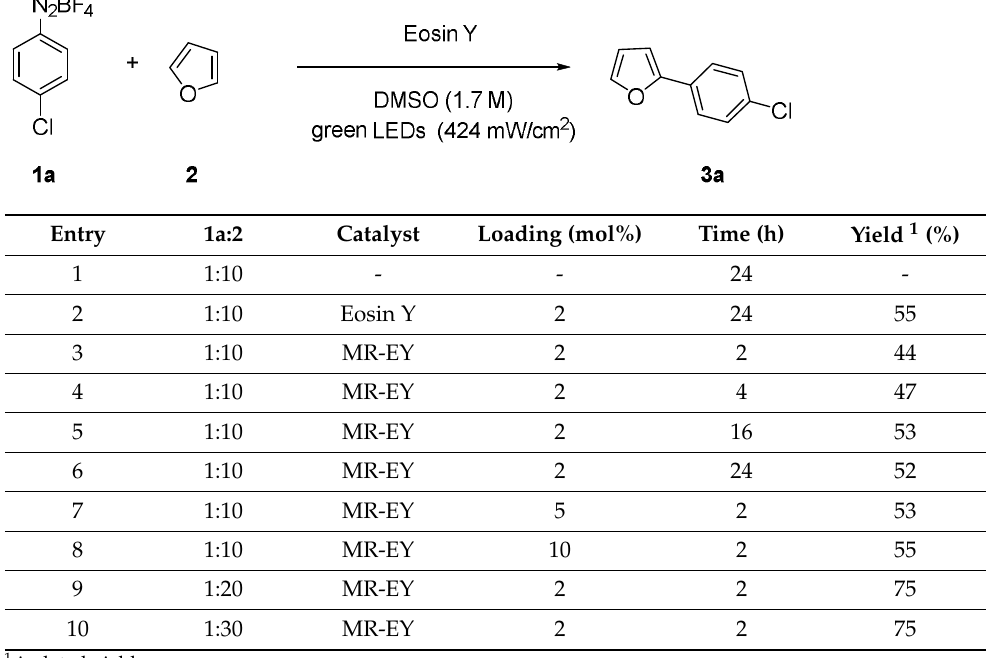
Molecules 2022 , 27 x FOR PEER REVIEW